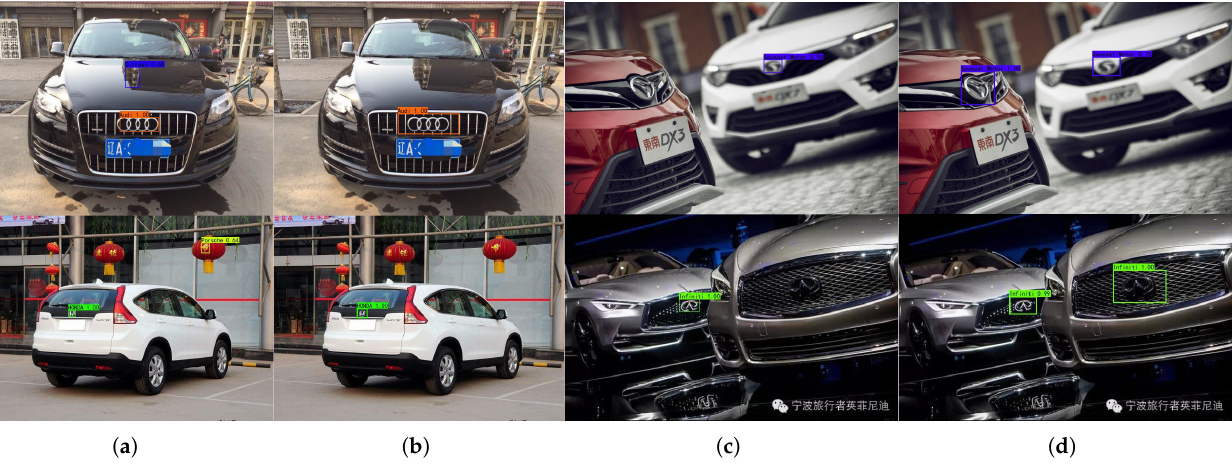
Figure 11. Comparison 1 and comparison 2 of the effect of YOLOv4 and My Model: ( a ) example 1, YOLOv4 detection results; ( b ) example 1, My Model detection results; ( c ) example 2, YOLOv4 detection results; ( d ) example 2, My model detection